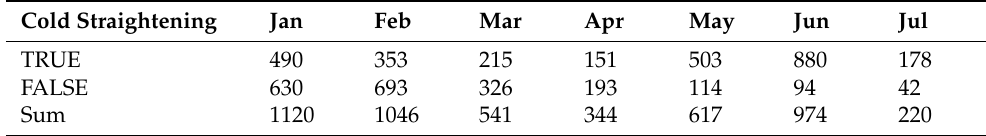
Table 2. Current situation of cold straightening from January to July 2020.